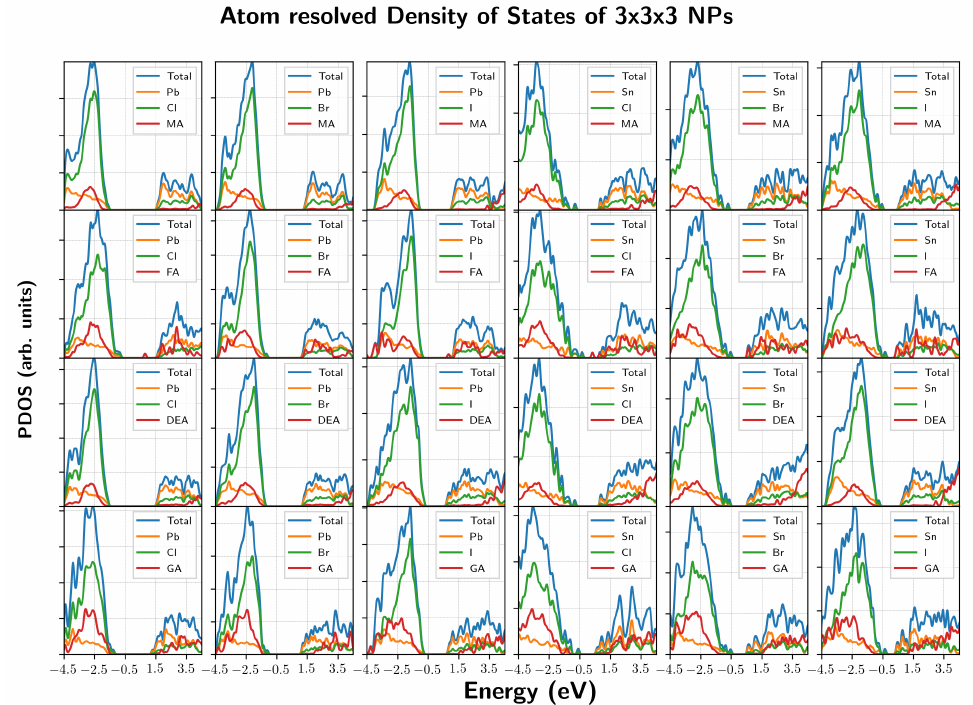
Figure 3. The projected density of states of all 3 × 3 × 3 nanoparticles